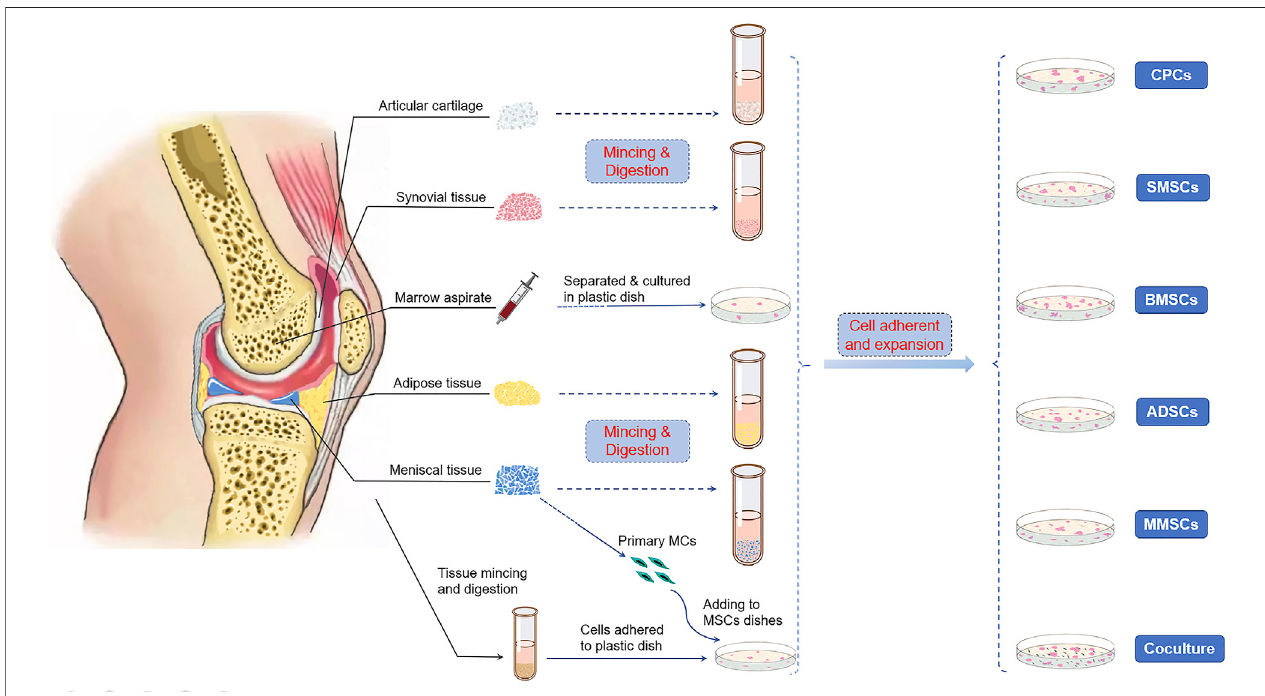
FIGURE 1 | Cell sources of multipotent stromal cells (MSCs) in meniscus repair and regeneration. Bone marrow, synovium, cartilage, adipose tissue, and the meniscusitselfwerereportedtobeabletoisolatestem/progenitorcells.Primarymeniscuscells(MCs)alsococulturedwithMSCsfromothertissuestoinducedirectional